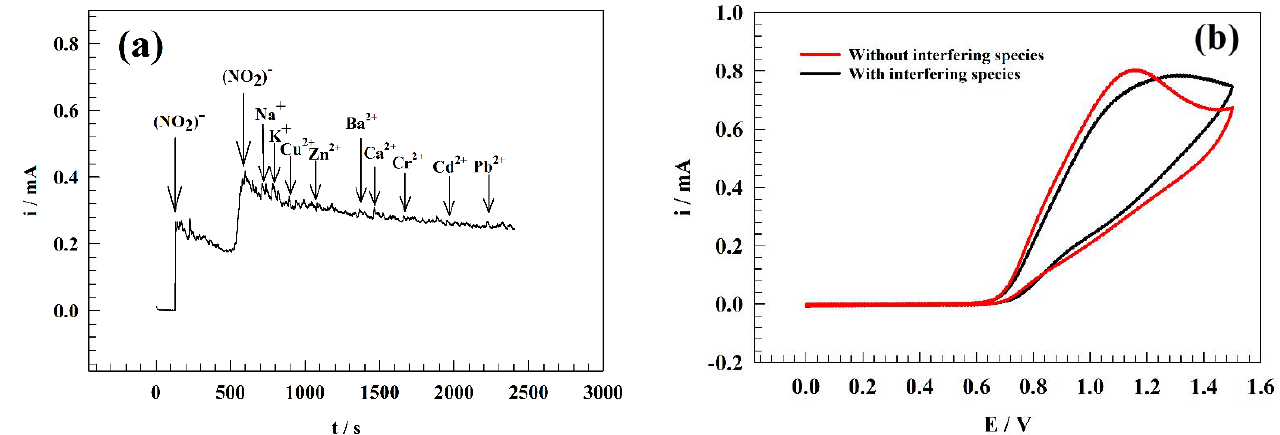
Figure 10. ( a ) Chronoamperogram of the modified GC/PANI/NiOnF electrode in the existence of different interfering ions. ( b ) CVs of GC/PANI/NiOnF in the presence and absence of interfering species.